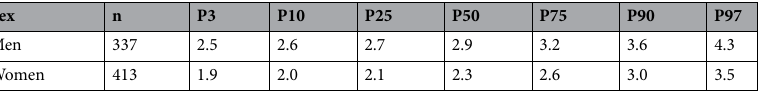
Table 3. Smoothed age-specific percentiles of relative STS power (W kg −1 ) in men and women with relative STS power values above the identified thresholds of ≥ 2.5 and 1.9 W kg −1 for men and women, respectively. P